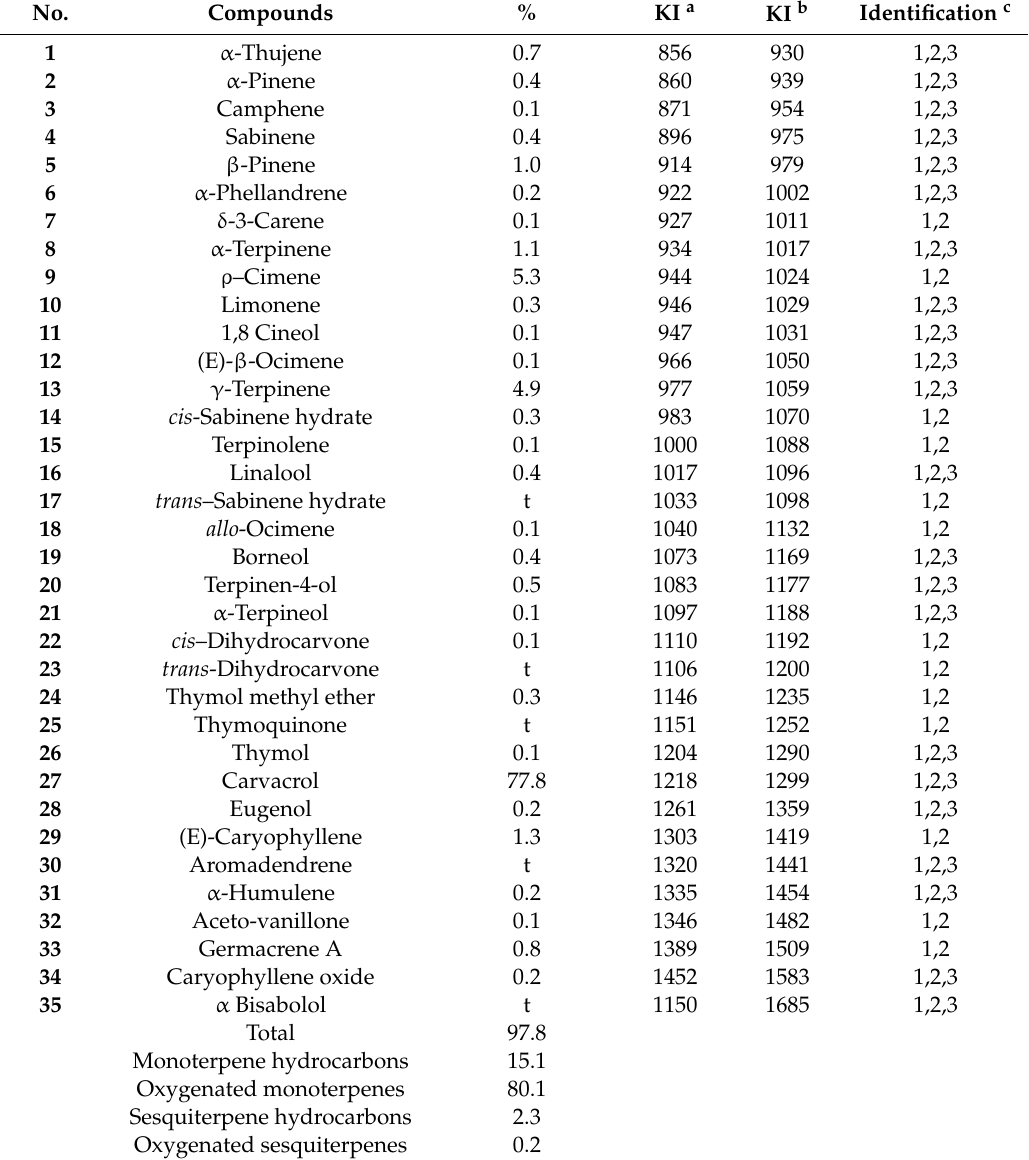
Table 1. Chemical composition of O. heracleoticum essential